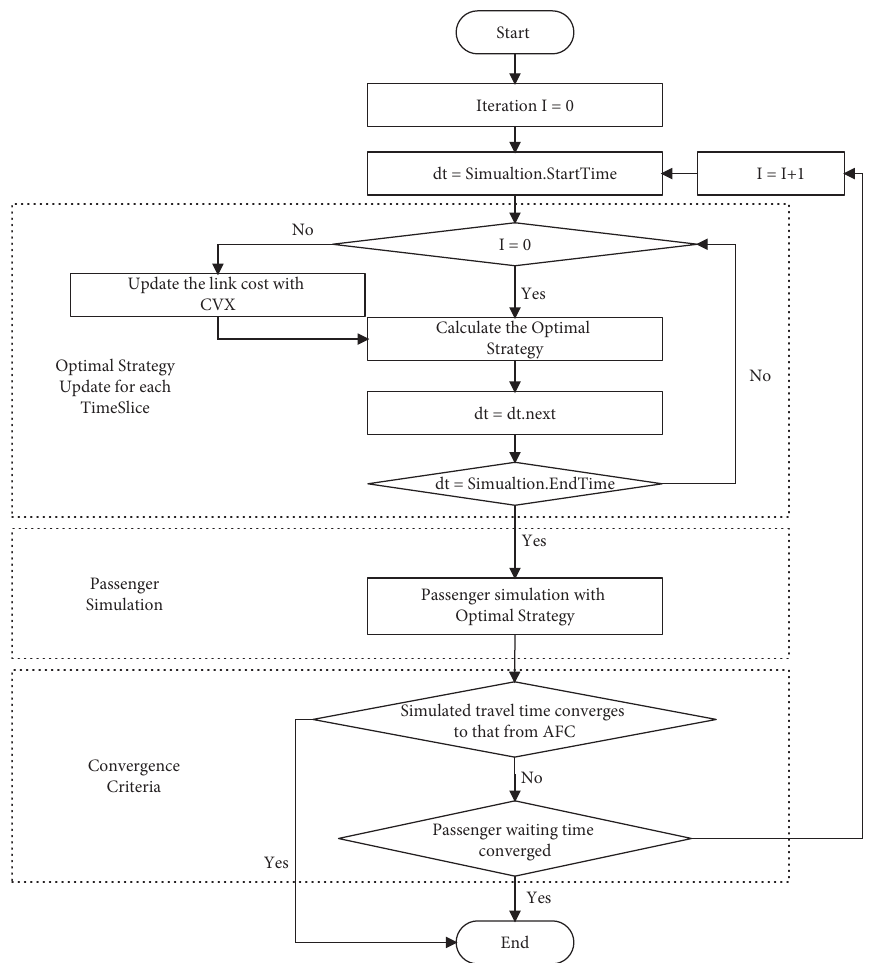
Figure 2: Dynamic simulation process for Beijing subway based on the optimal